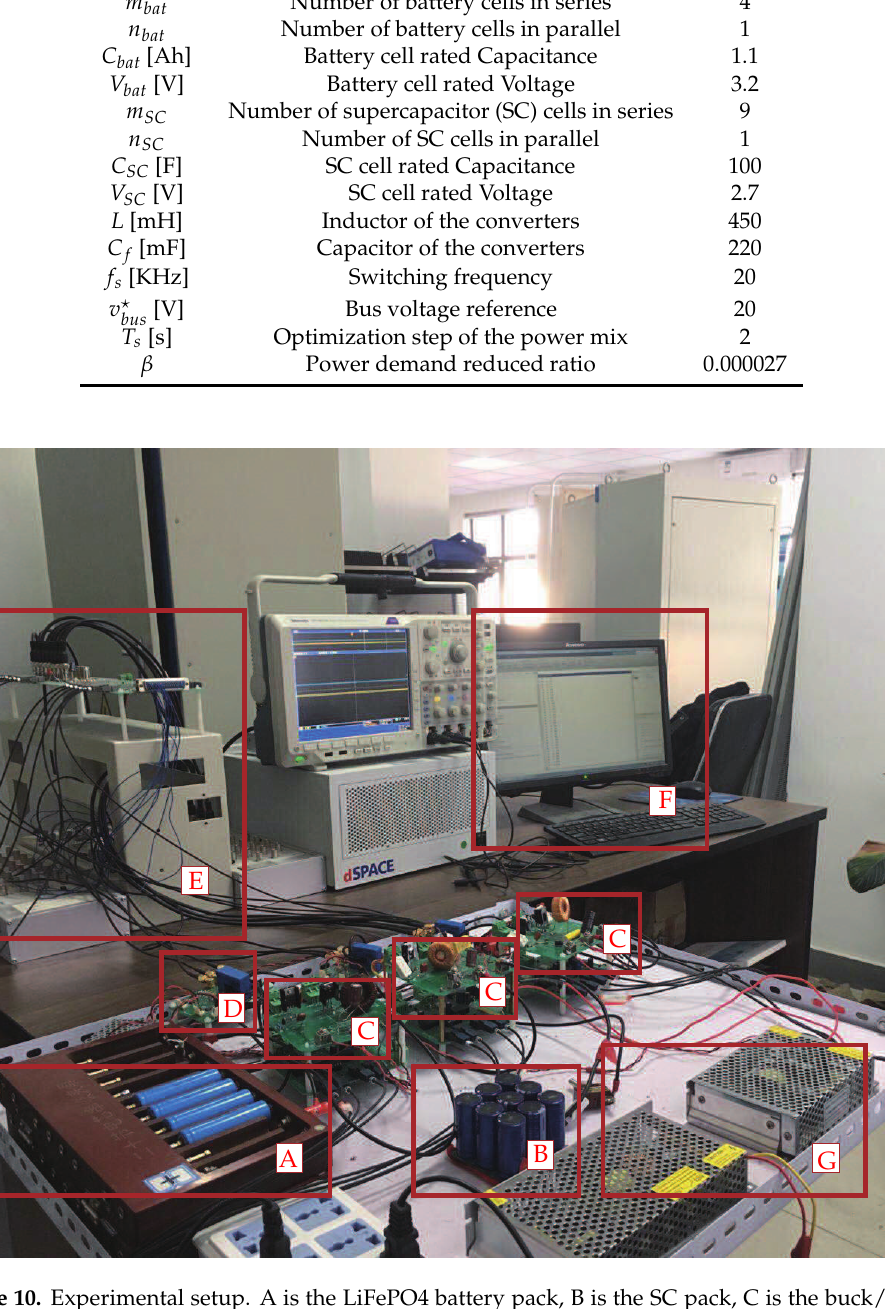
Figure 10. Experimental setup. A is the LiFePO4 battery pack, B is the SC pack, C is the buck/boost converter, D is the sensor board, E is the dSPACE board, F is the simulation computer, and G is the power of the sensor board and drive